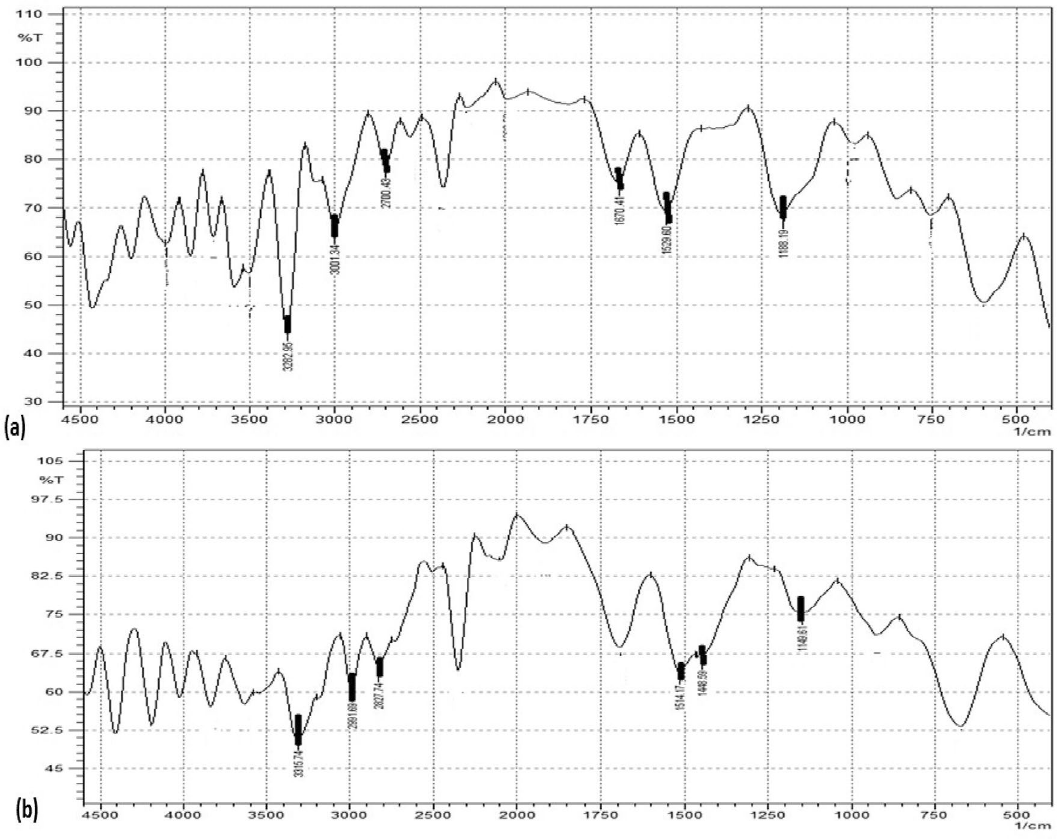
PAMAM generation